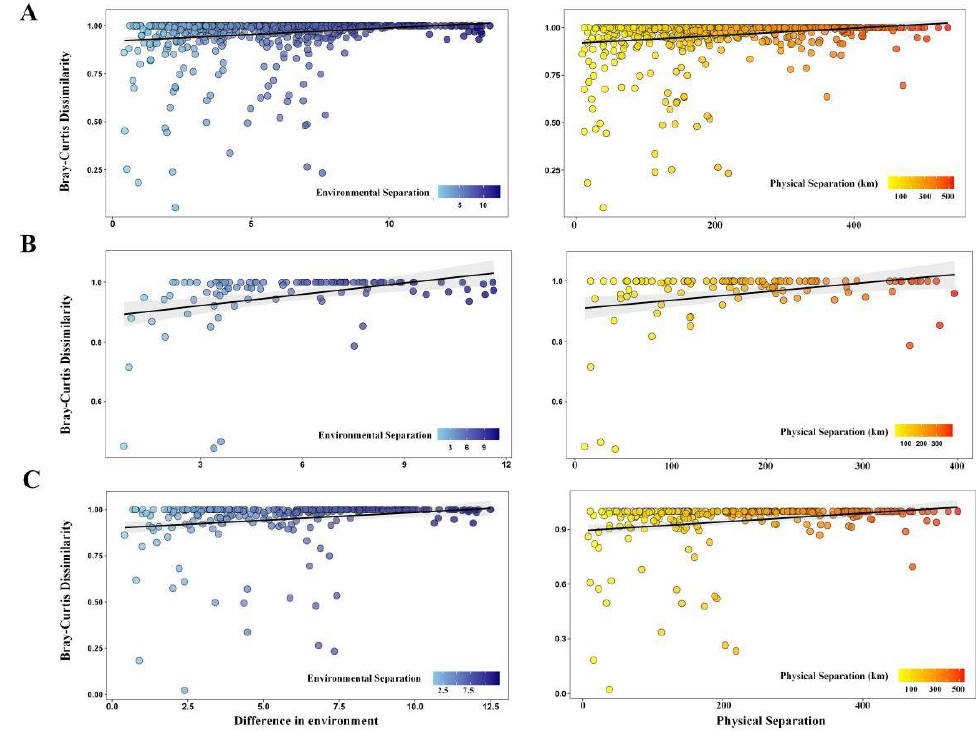
Figure 8. Variation in β-diversity along environmental/geographic distance; ( A ) whole community; ( B ) artificial disturbance community; ( C ) natural community.